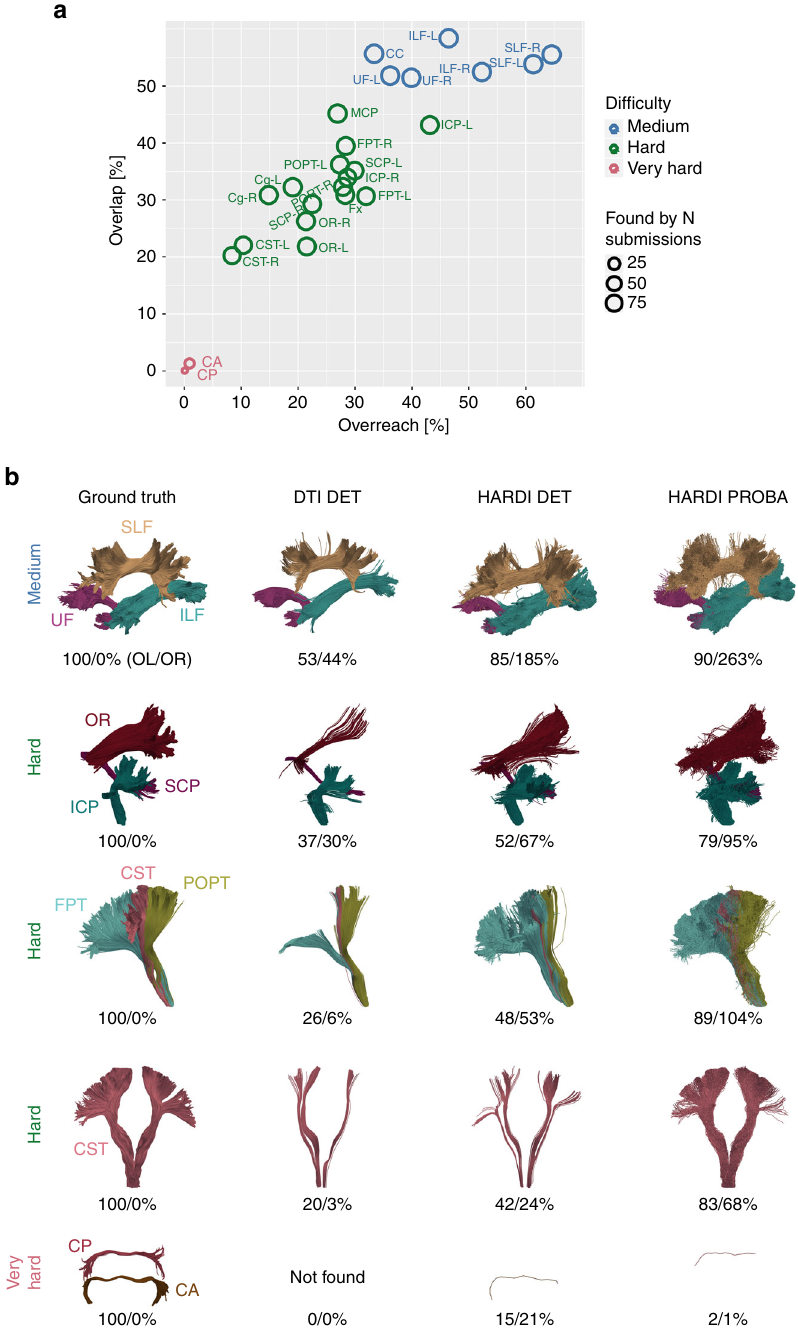
Fig. 3 Tractography identi fi es most of the ground truth bundles, but not their full extent. a Overview of scores reached for different bundles in ground truth. Average overlap (OL) and average overreach (OR) scores for the submissions (red: very hard, green: hard, blue: medium, for abbreviations see Fig. 1). b Representative bundles for DTI deterministic (DET) tracking come from submission 6/team 20, high angular resolution diffusion imaging (HARDI) deterministic tracking from submission 0/team 9, and HARDI probabilistic (PROBA) tracking from submission 2/team 12 (see Supplementary Note 5 for a discussion of these submissions). The fi rst column shows ground truth VBs for reference. The reported OL and OR scores correspond to the highest OL score reached within the respective class of